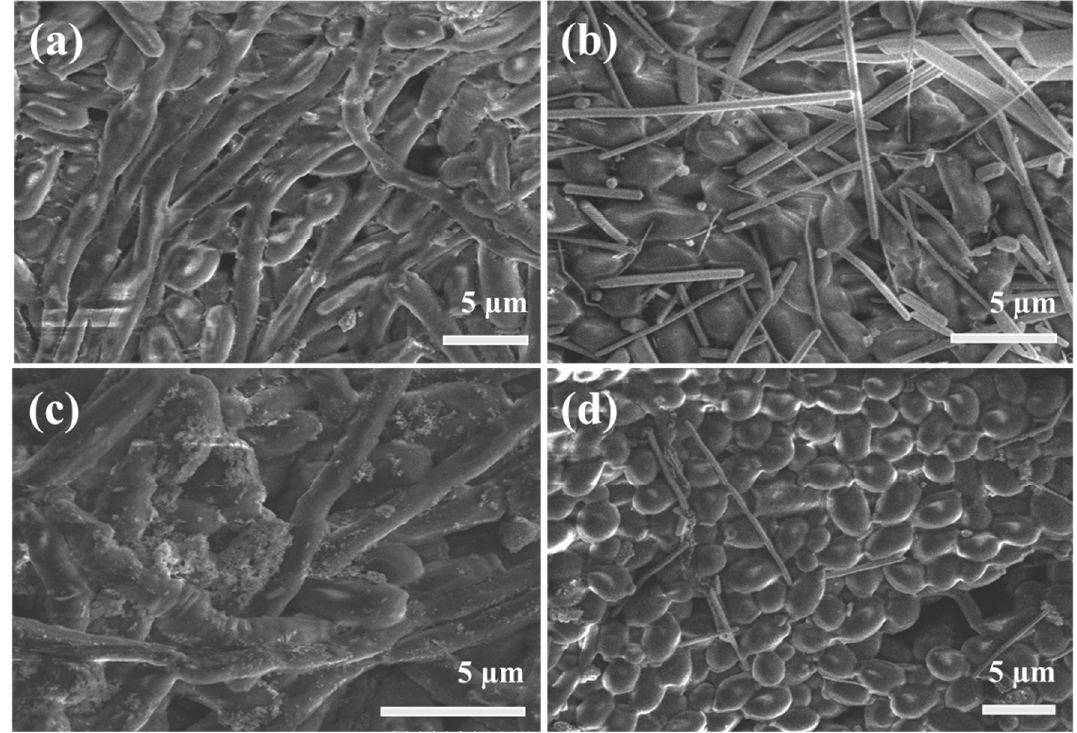
Figure 6. SEM images of ( a ) control Candida biofilm and biofilms treated with ( b ) 300 µg/mL of AgNWs, ( c ) 300 µg/mL of ZnFe 2 O 4 NPs, and ( d ) 100 µg/mL of ZnFe 2 O 4 @AgNWs hybrid nanostructures. The biofilms were formed for 24 h.